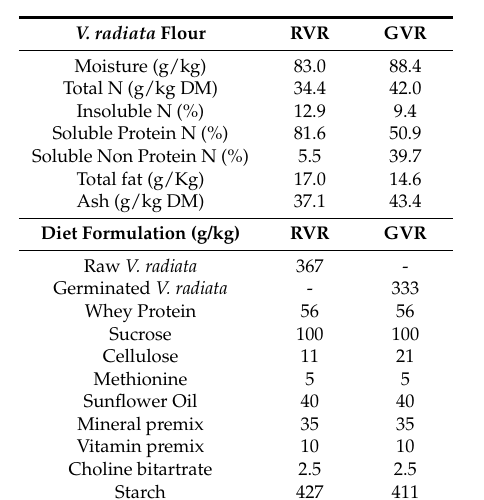
Table 1. Composition of raw and 4 day-germinated V. radiata flours and experimental diet